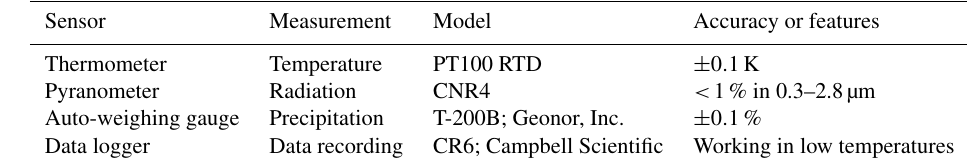
Table 1. The sensors mounted on the AWS at ELA and their technical features.